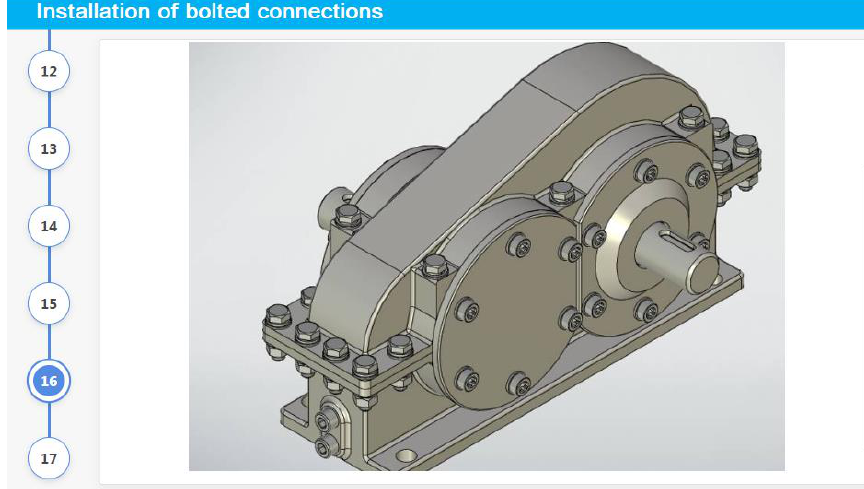
Fig. 16 . Final view of the